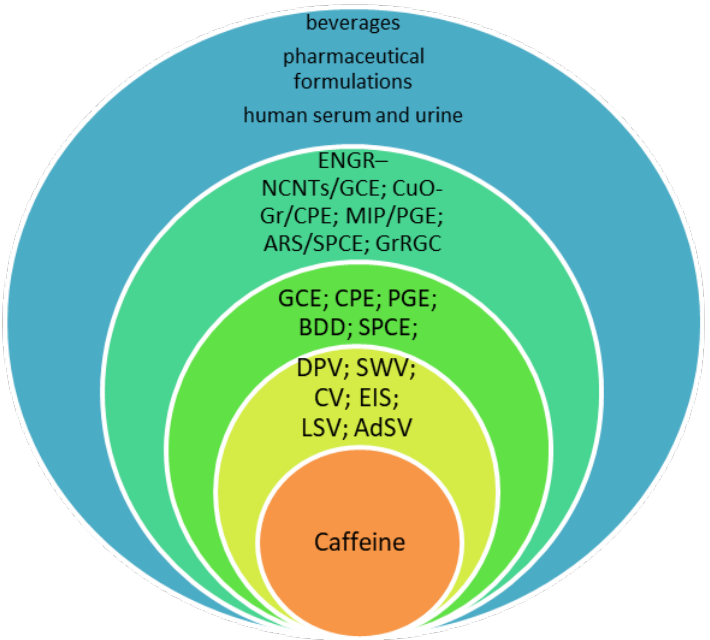
Figure 9. Illustration of the currently available data regarding methods, sensors, modified sensors, and tested real samples for caffeine determination.